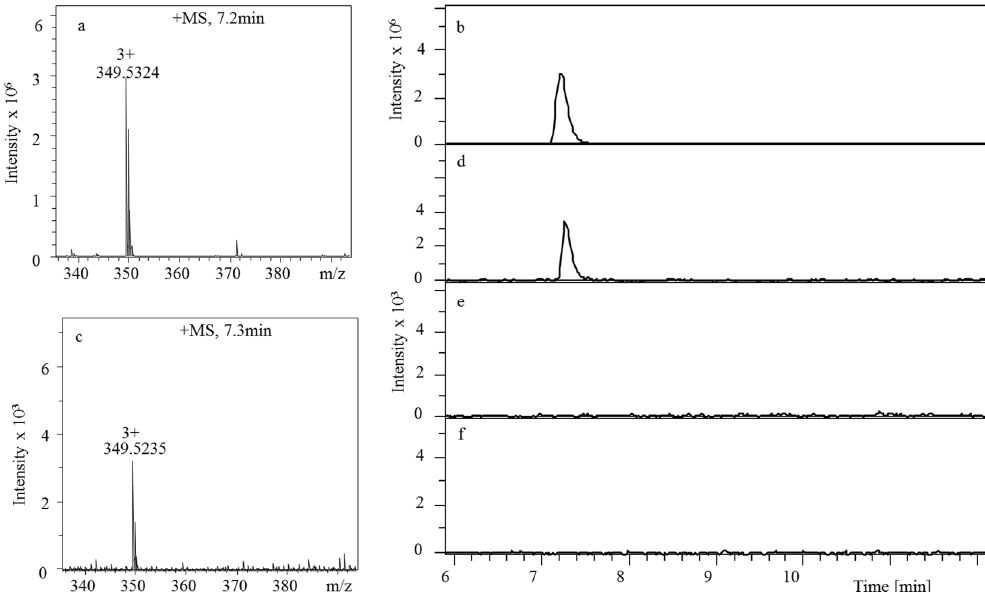
Figure 5. Proof of translocation of Ang II through large populations of lysenin channels inserted into a planar lipid membrane. ( a ) The MS of reference Ang II solution (100 ng) identified the peptide at m/z = 349.5 (z = 3 + ). ( b ) LC chromatogram of reference Ang II solution. The peptide molecules translocated into the trans reservoir at − 100 mV for 36 hours were detected and identified by MS ( c ) and LC ( d ). Application of a + 100 mV voltage ( e ) or channel blockage by chitosan ( f ) did not allow LC detection of Ang II into the trans